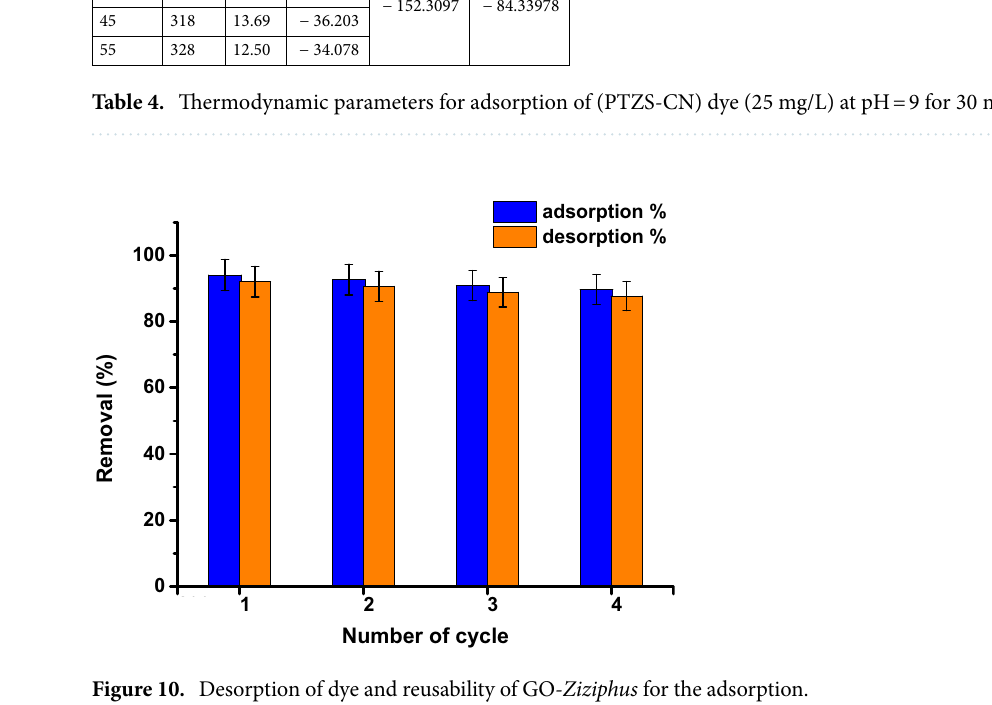
Figure 10. Desorption of dye and reusability of GO- Ziziphus for the